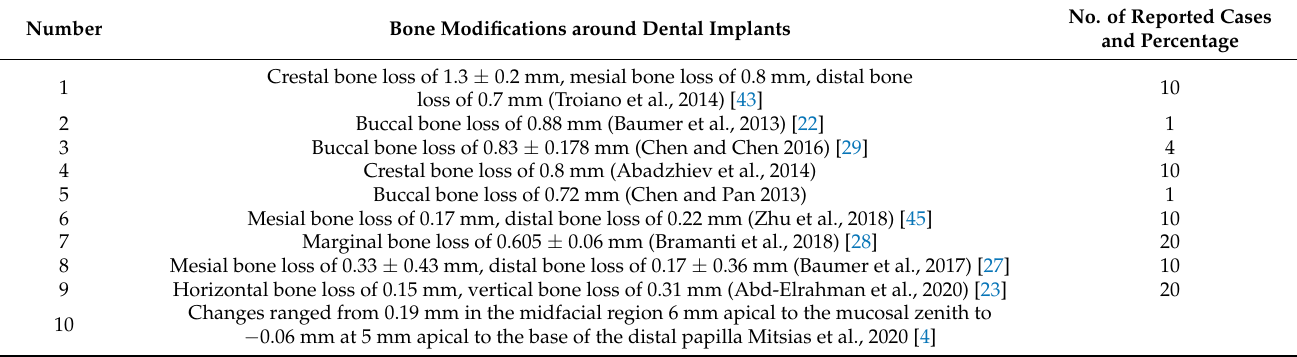
Table 2. Clinical studies and marginal bone resorption.